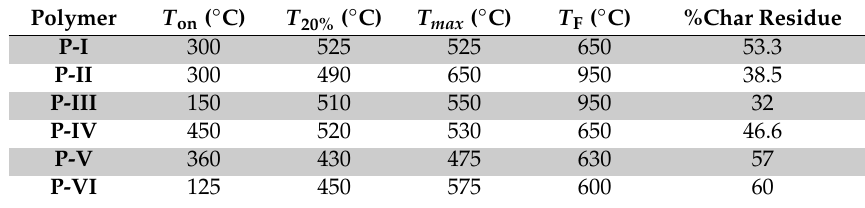
Table 2. Thermal degradation data of polyazomethines performed by thermogravimetric analysis.